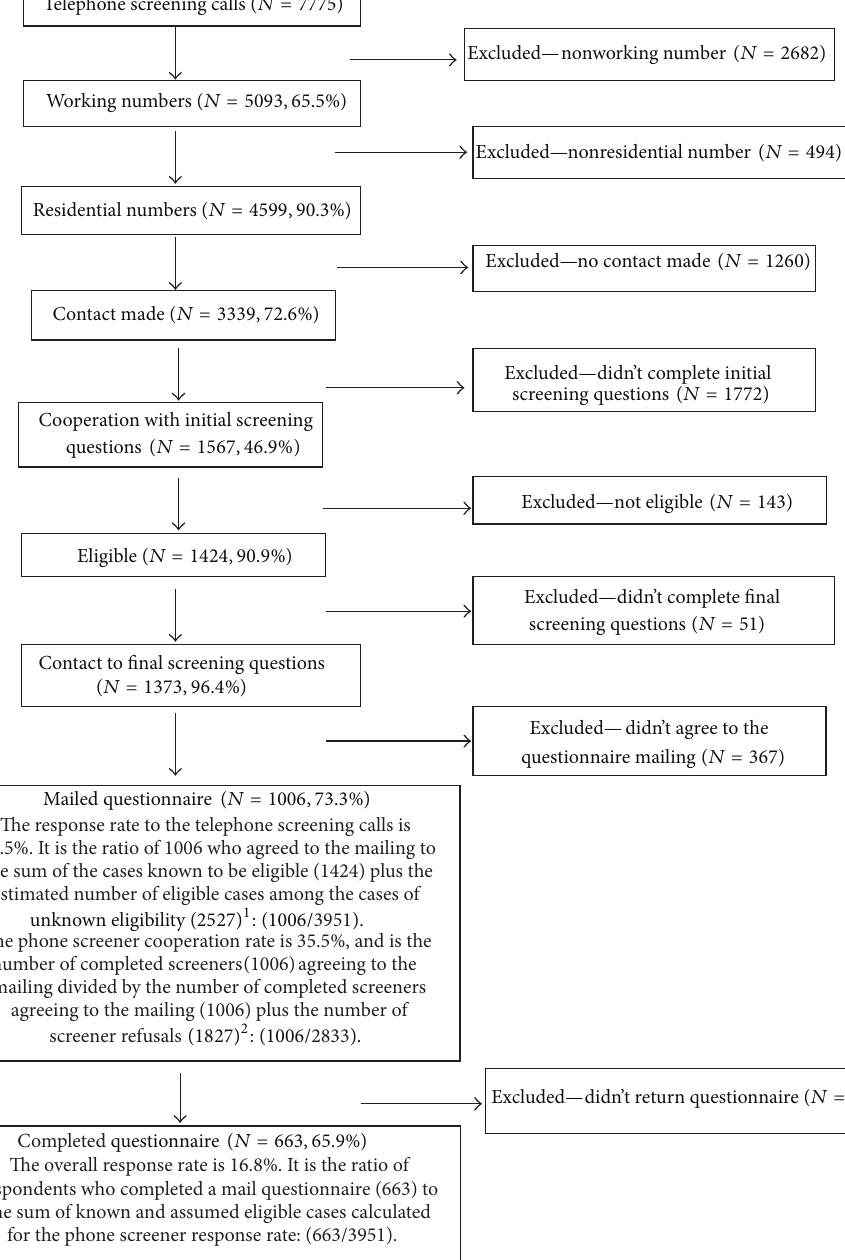
Figure1:AsummaryofsampleNsandresponseratesateachdecisionpoint. 1